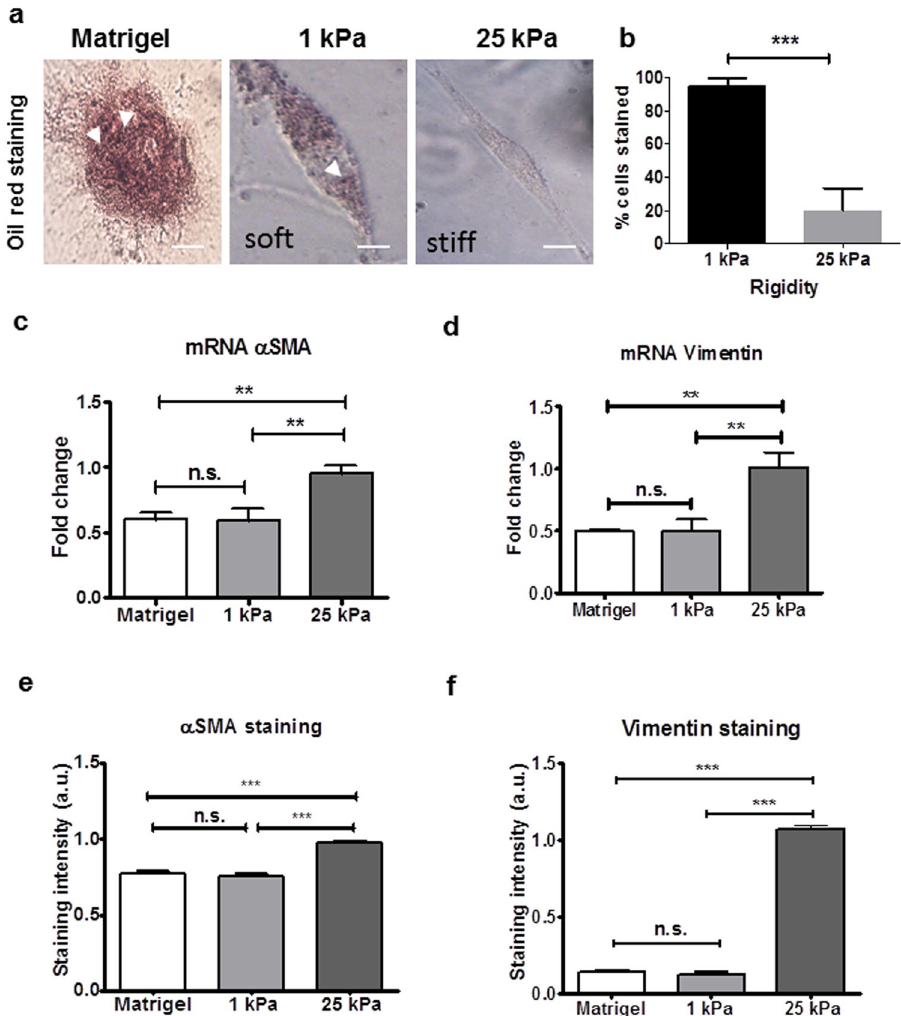
Figure 1. Stiff matrices induce PSC activation. ( a ) Bright-field images of Oil Red O stained PSCs on Matrigel, soft and stiff matrices for 6 days. Scale bar 25 μ m. ( b ) Quantification of Oil Red O staining after 24-hour culture on soft or stiff PAA matrices showed a significant reduction in staining levels on stiff matrix when compared to soft matrix, indicating cellular activation almost entirely on stiff matrix rigidities. ( c , d ) pPCR mRNA levels of α SMA and vimentin for conditions represented in ( a ). ( e , f ) Quantification of staining intensity for α SMA and vimentin for conditions represented in ( a ), images in Supplementary Fig. 3. In all cases, histogram bars represent mean ± SEM. Representative of 3 independent experiments with more than 20 cells analysed in ( b , e , f ), *** p < 0.001, ** p <